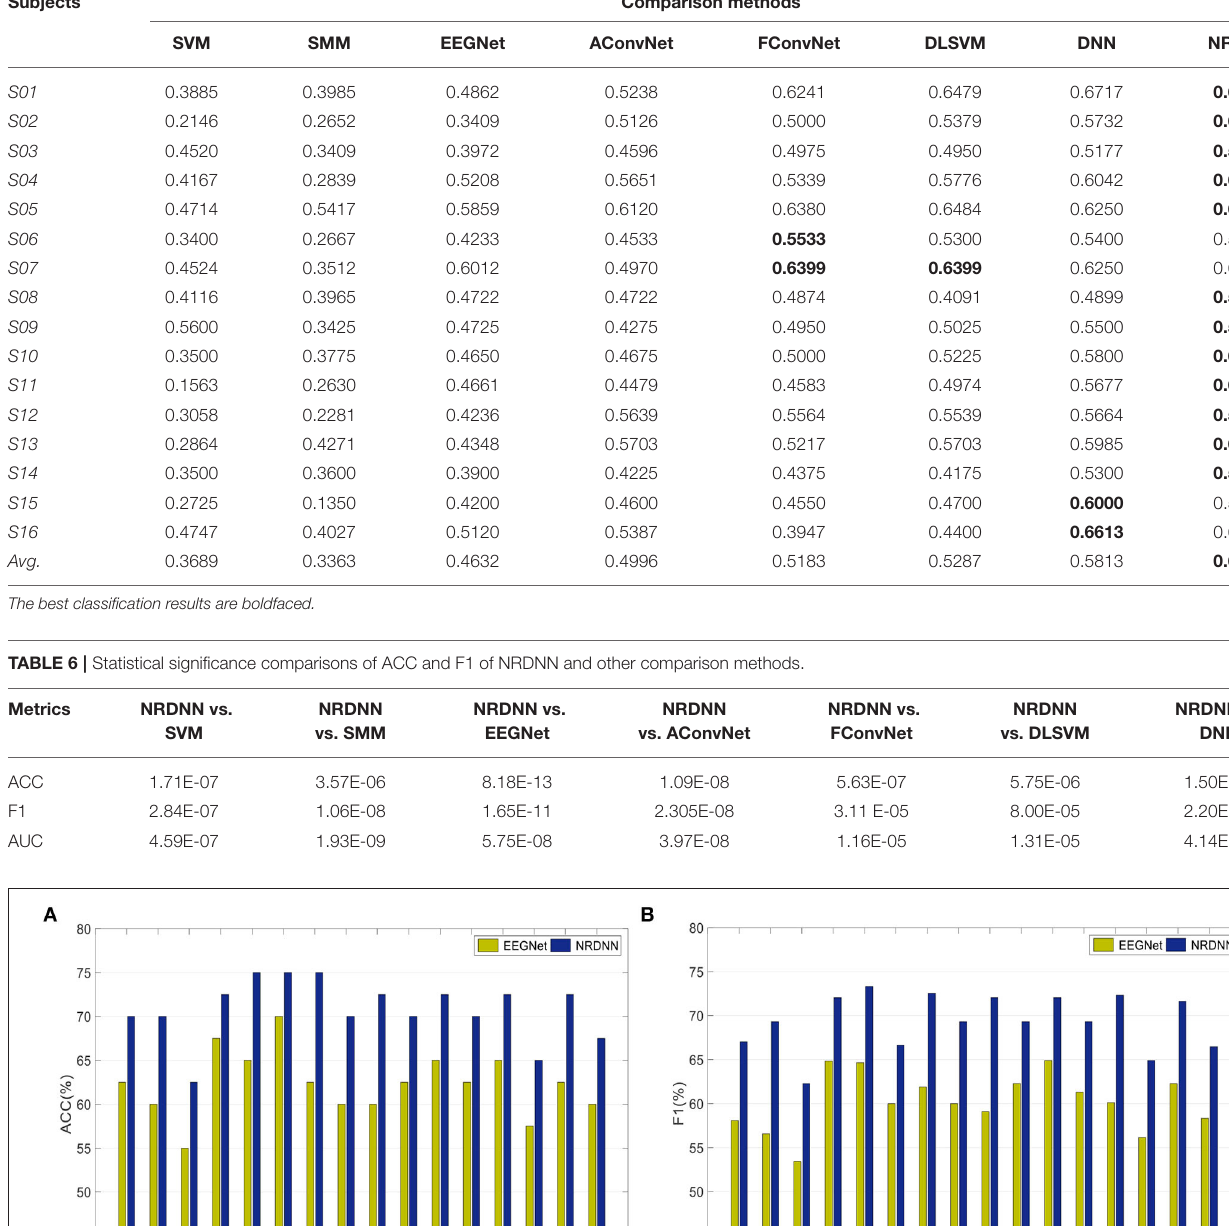
TABLE 5 | Classification performances (AUC) of our NRDNN against the comparison methods. Subjects